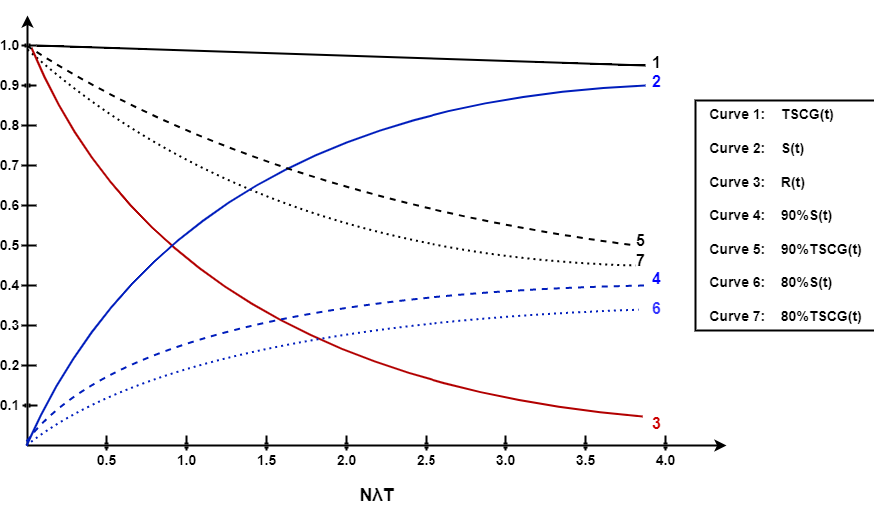
Figure 11. TSCG ( t ) when inputs do not have the same probability of occurrence and part of the inputs are not available: (1) all input values are available, (5) a case of 90% input values available, and (7) a case of 80% input values